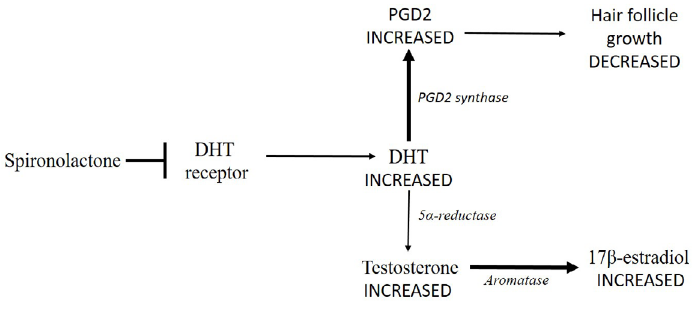
Figure 2. Spironolactone impedes DHT to bind its receptor ( ) leading to a DHT accumulation. Consequently, DHT transformation into testosterone is delayed (thinner arrow), so that testosterone concentration increases. Testosterone conversion